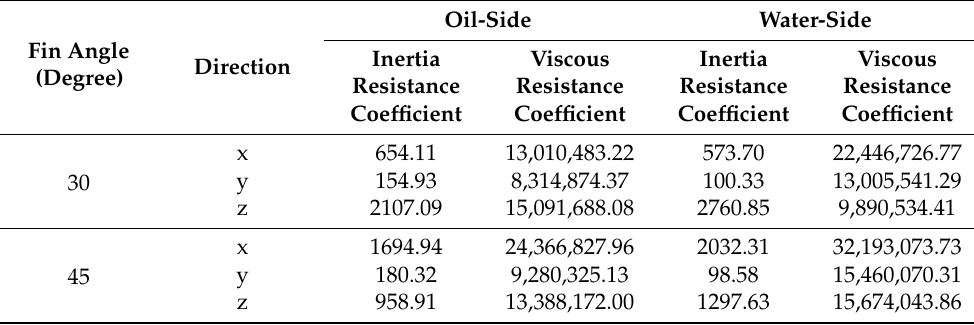
Table 3. Porous media parameters at different fin